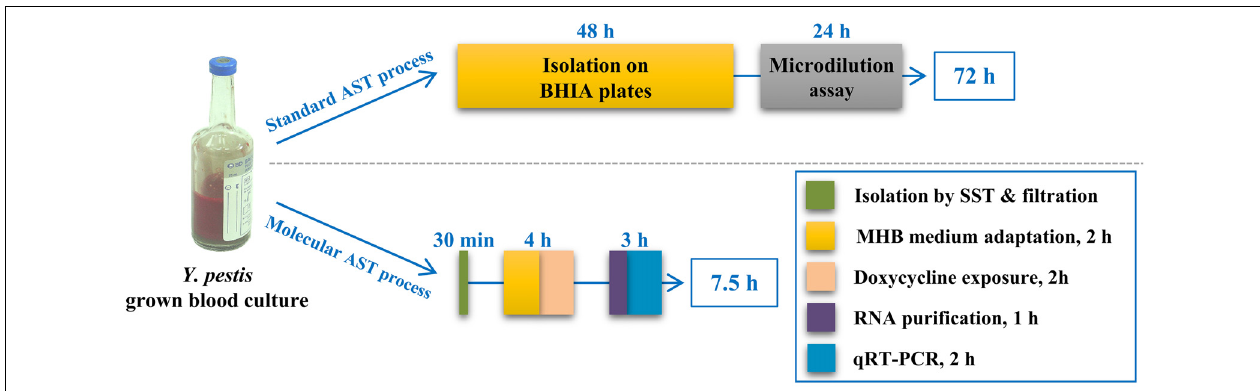
FIGURE 4 | Schematic presentation of the standard and molecular ASTs for the determination of Y. pestis susceptibility to doxycycline. The scheme presents the steps of the standard CLSI-based and the molecular susceptibility tests for the determination of the doxycycline susceptibility of Y. pestis originating from blood cultures. The duration of each step is indicated, as well as the overall test